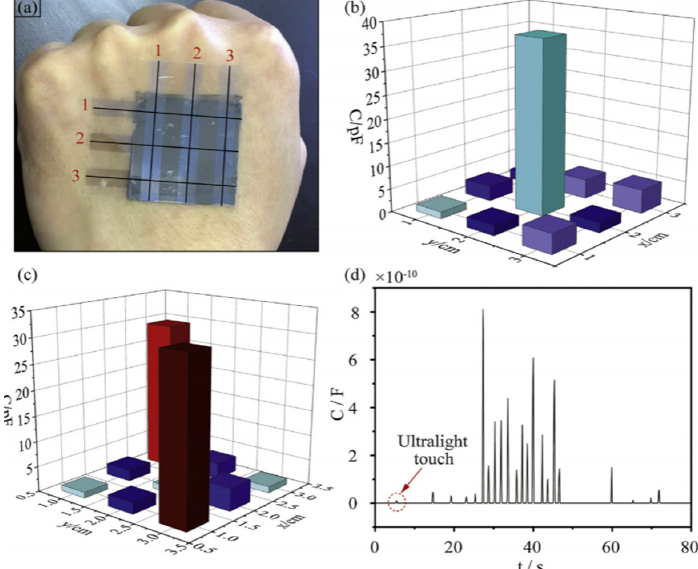
Figure 21. Wearable sensor for finger pressure sensing: ( a ) The diagram of sensor network attached on the hand. ( b , c ) The measured capacitance changes when a single and double pressure applied on the sensor network. ( d ) Plots showing the relative changes in capacitance of the sensor when it was subjected to dynamic pressing and releasing cycles. Reprinted with permission from [140].